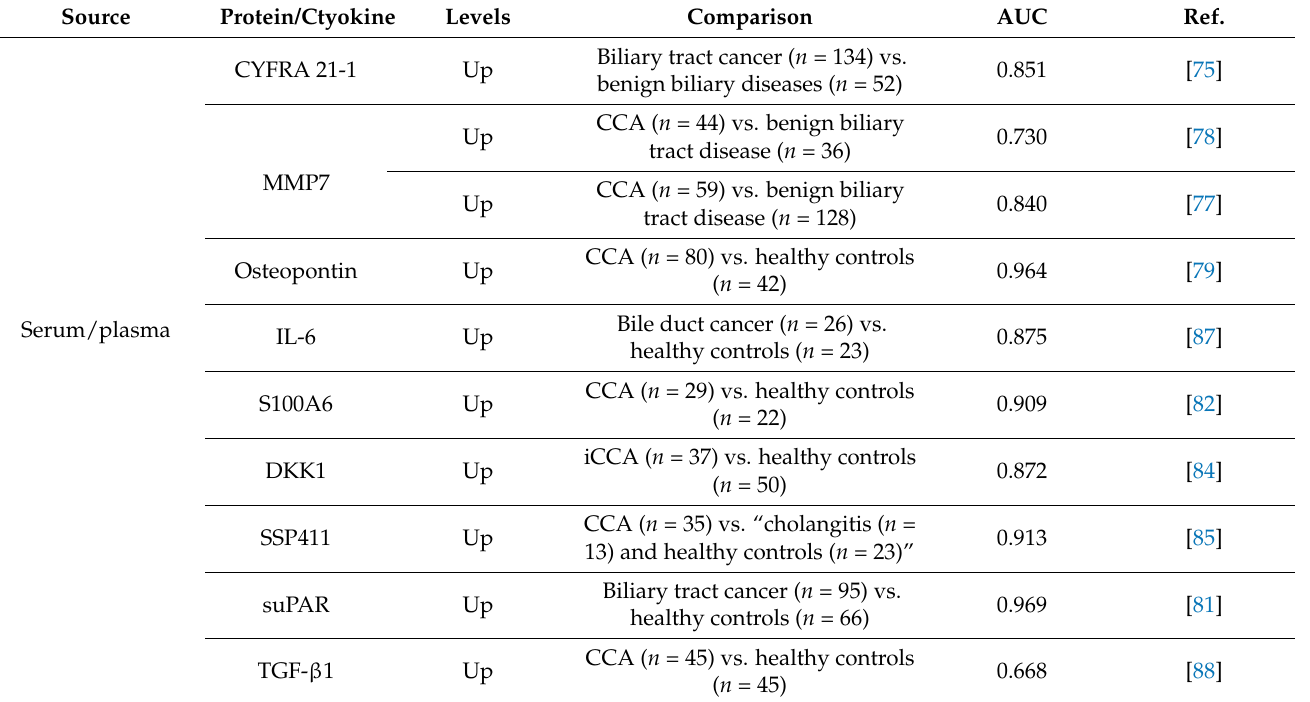
Table 2. Circulating protein/cytokines with potential diagnostic value for